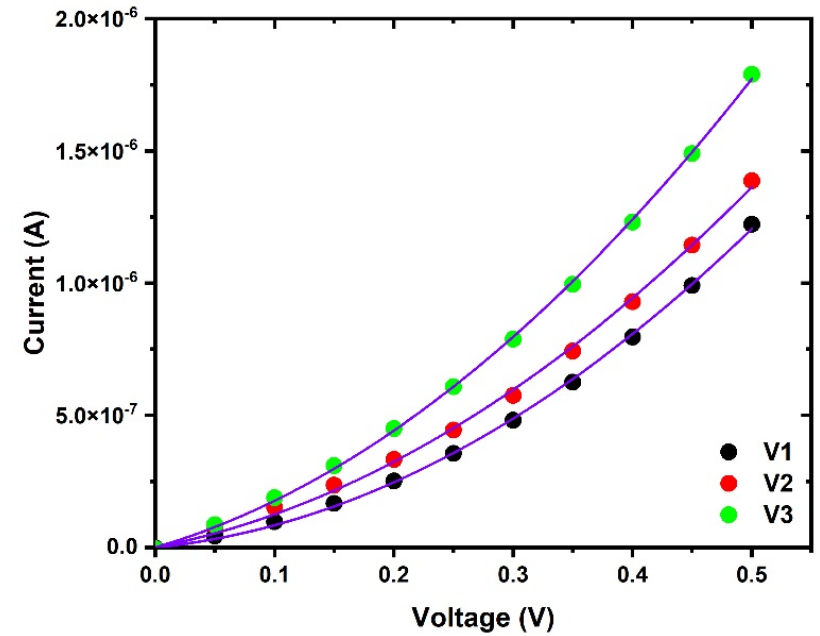
Table 4. The fitting parameters α and φ extracted from the QPC model fit for HRS curves and the determined ratios of T B /R B .